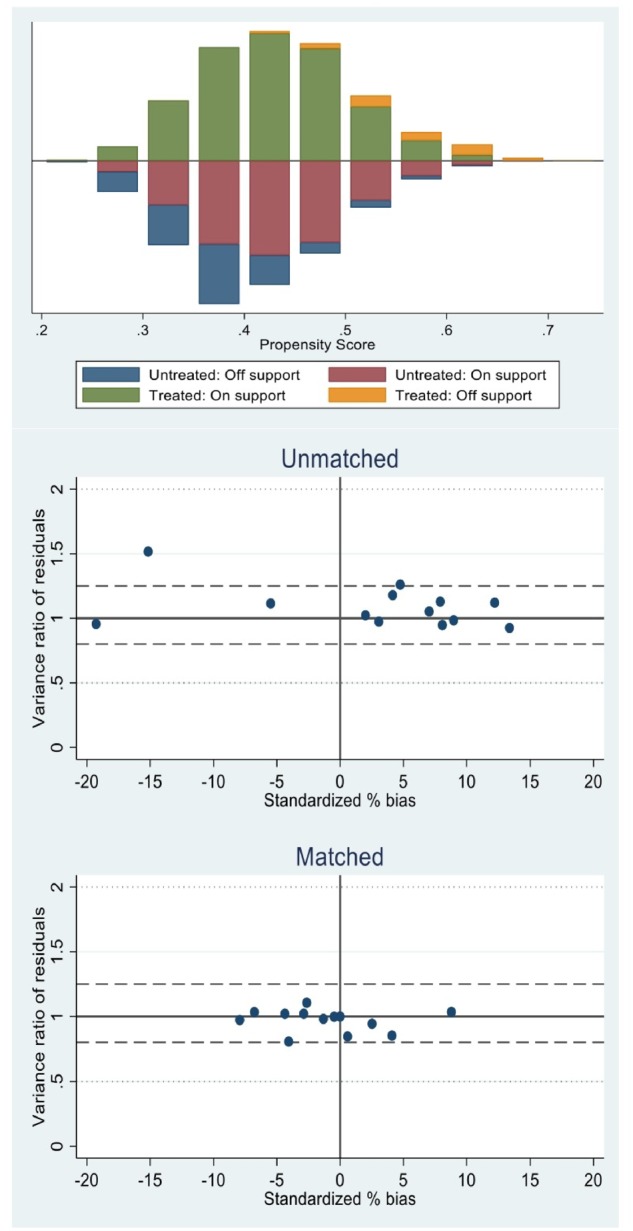
Distribution of propensity scores using nearest neighbour matching for medical utilization across treatment and comparison groups and representation of standardized bias between matched and unmatched samples, Ghana 2012–13.